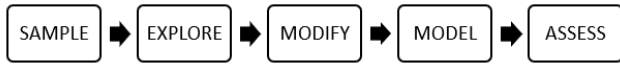
Figure 1. Phase of the SEMMA methodology